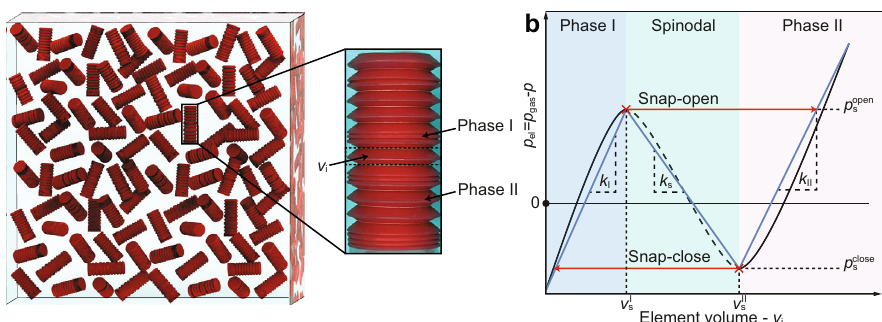
Fig. 1 Illustration of a meta fl uid. a Schematic view of a meta fl uid containing encapsulated gas within multistable capsules, immersed with a second fl uid. b Pressure ( p el ) vs. volume ( v i ) relation (shown by black continuous and dashed line) and the tri-linear approximation (shown by blue line) for each individual bi-stable element ( i ) in the multi-stable capsule, where phase I, spinodal, and phase II regions are indicated. The spinodal region de fi nes the region of negative stiffness that separates between phase I and phase